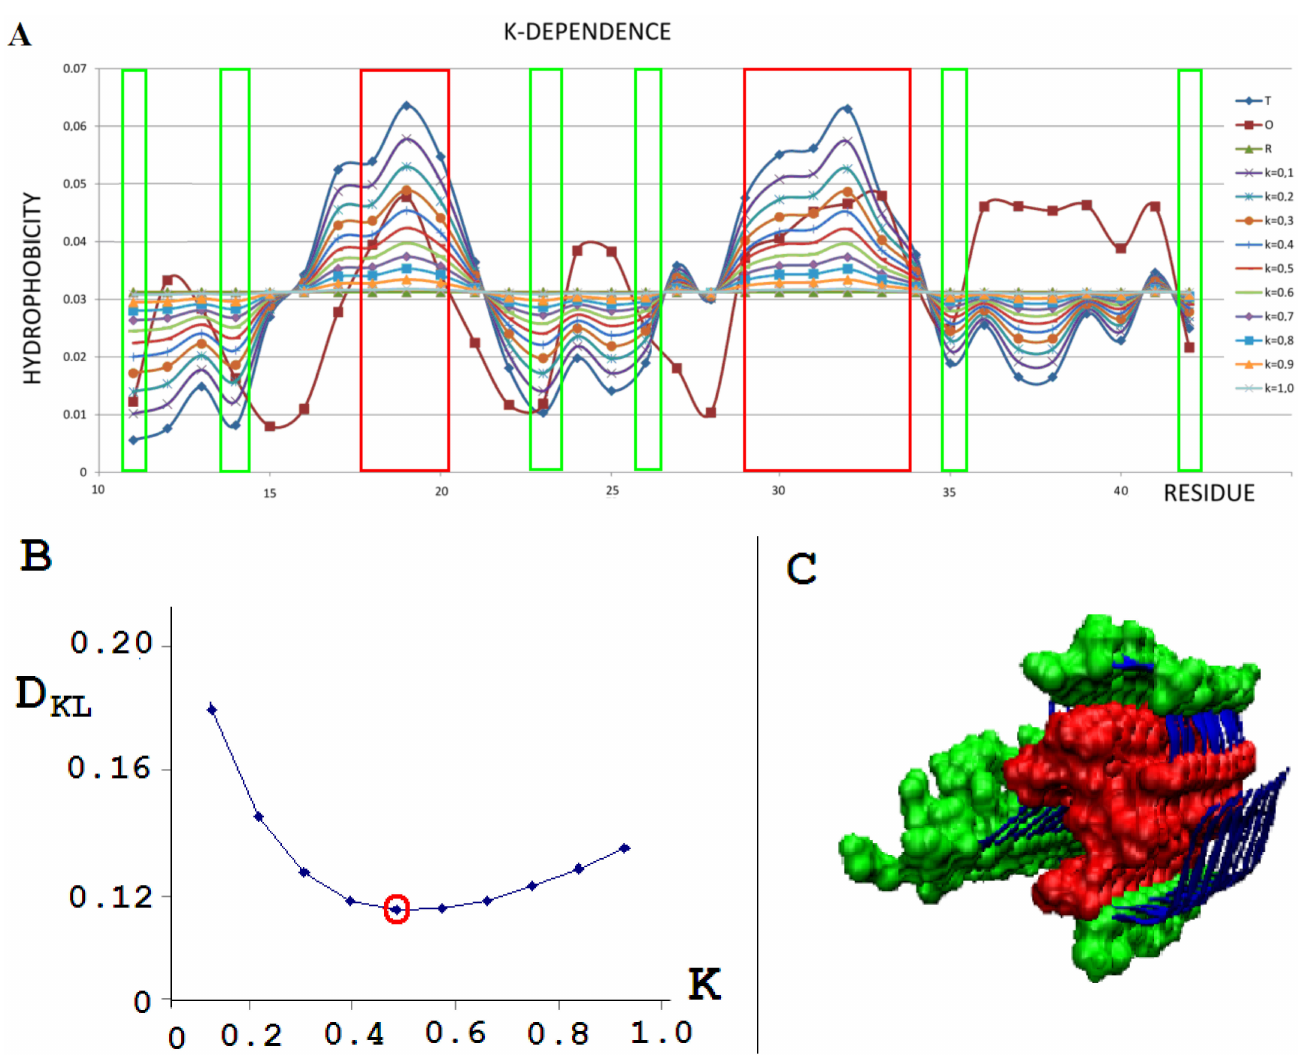
Figure 1. External force field analysis for a single-chain A β -amyloid(11–42) (PDB ID 5KK3) [38]. ( A )—Sample of 10 distribu- tions for different values of K: T - blue; O - brown; R - green, all other colors as shown in legend represent the modification of T distribution by different K values. ( B )—D KL dependence on K to find the lowest D KL between modified T and O distribution. ( C )—3D presentation of protofilament of A β -amyloid(11–42). Red residues (space filling), high hydrophobicity accordant with the T profile; green residues (space filling), low hydrophobicity accordant with the T distribution. Fragments distinguished according to frames given in